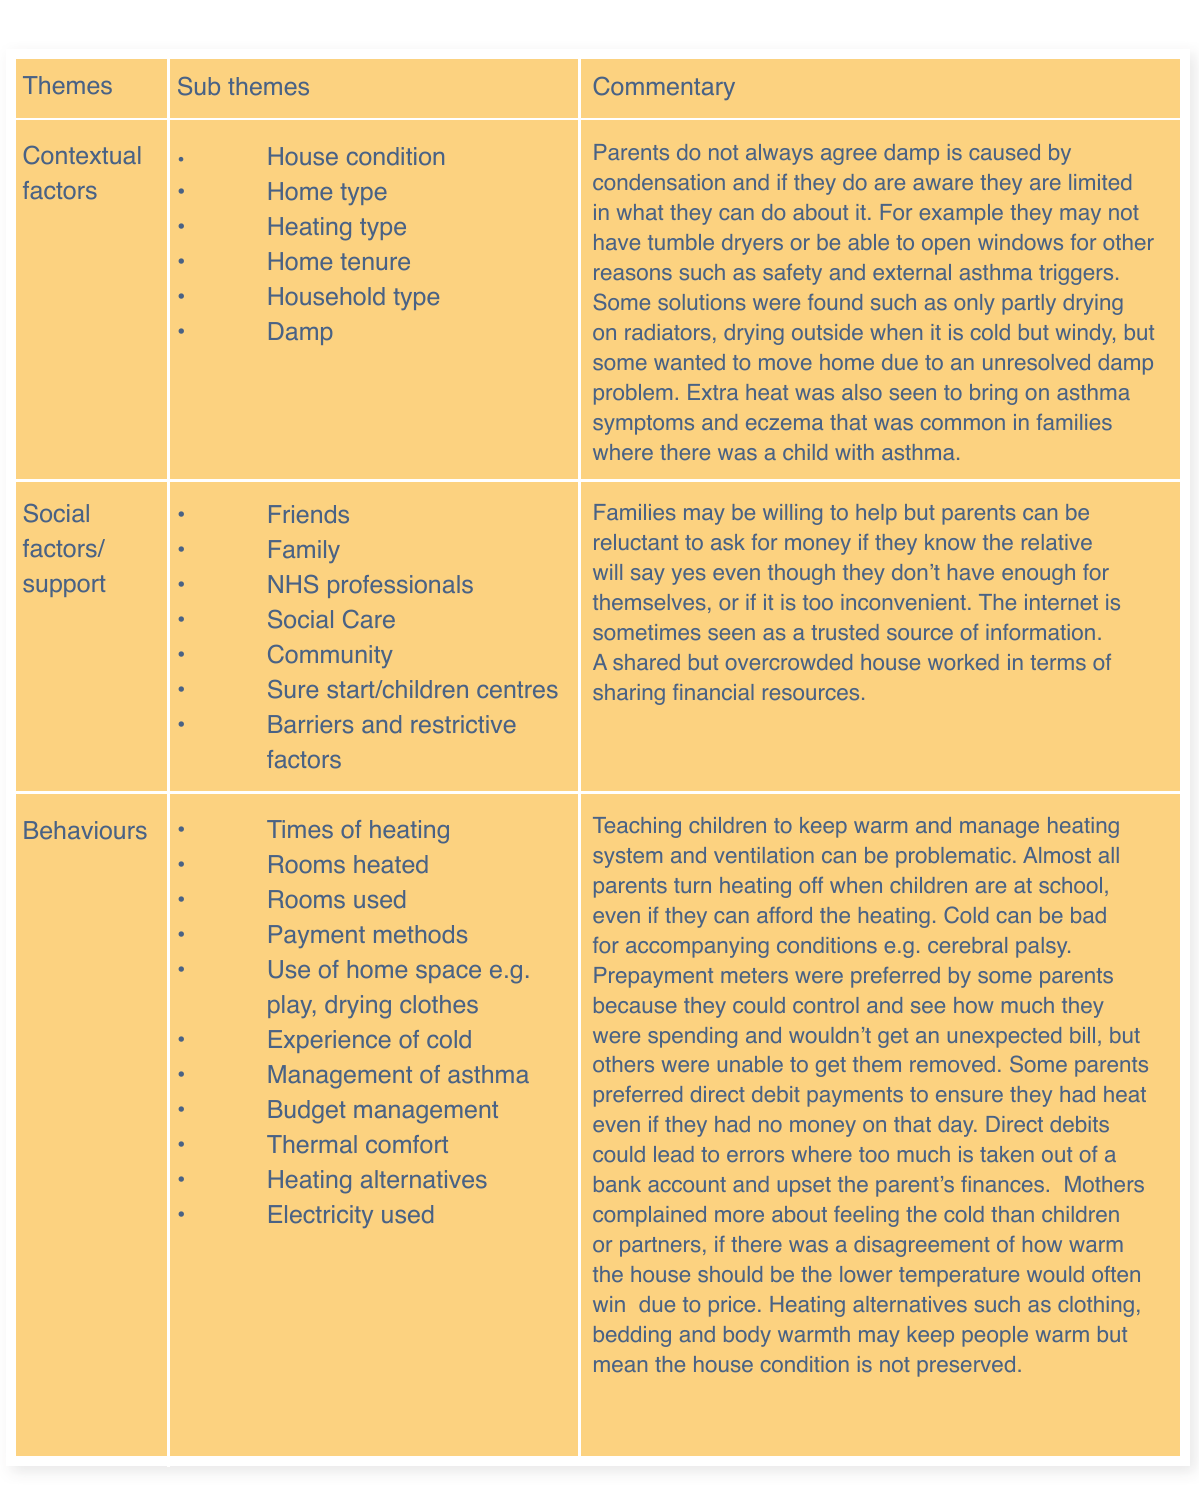
Table 5. Themes from household interviews, young people and school focus groups